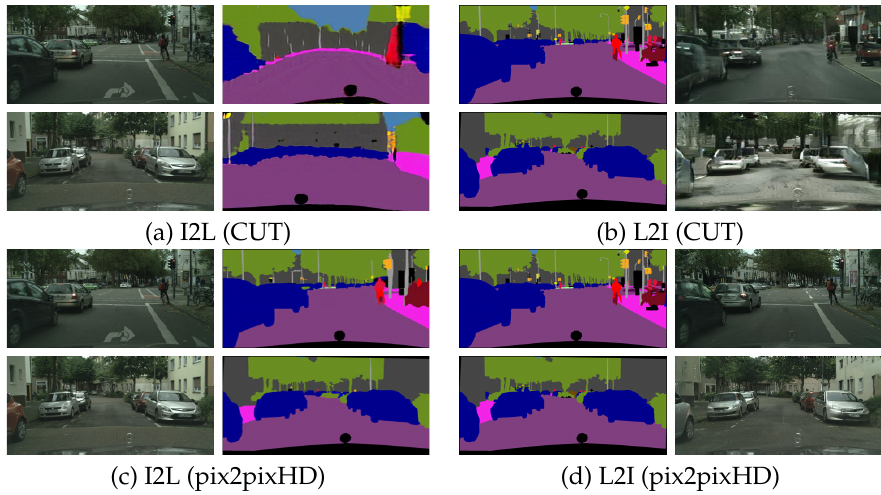
Figure 8. I2L and L2I style transfer results for the respective GANs in